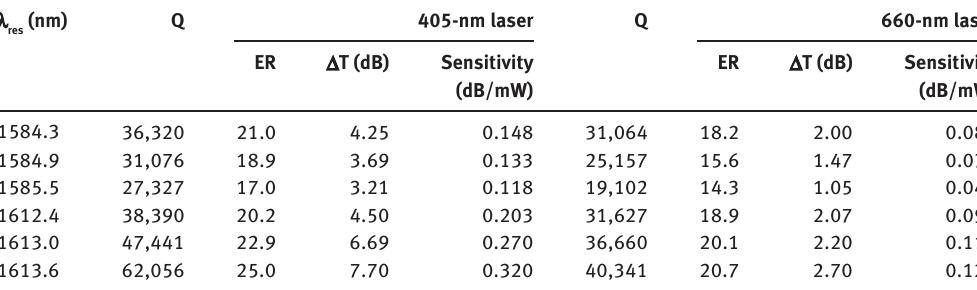
Table 1: Resonance Q, ER, Δ T, and the sensitivity with 405-/660-nm laser pumping. λ (nm) res